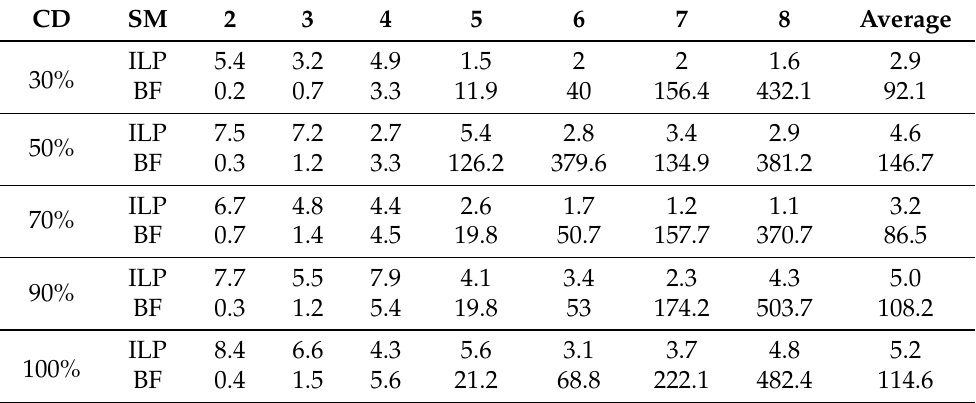
Table 2. Comparison of the running times of the ILP and the brute force